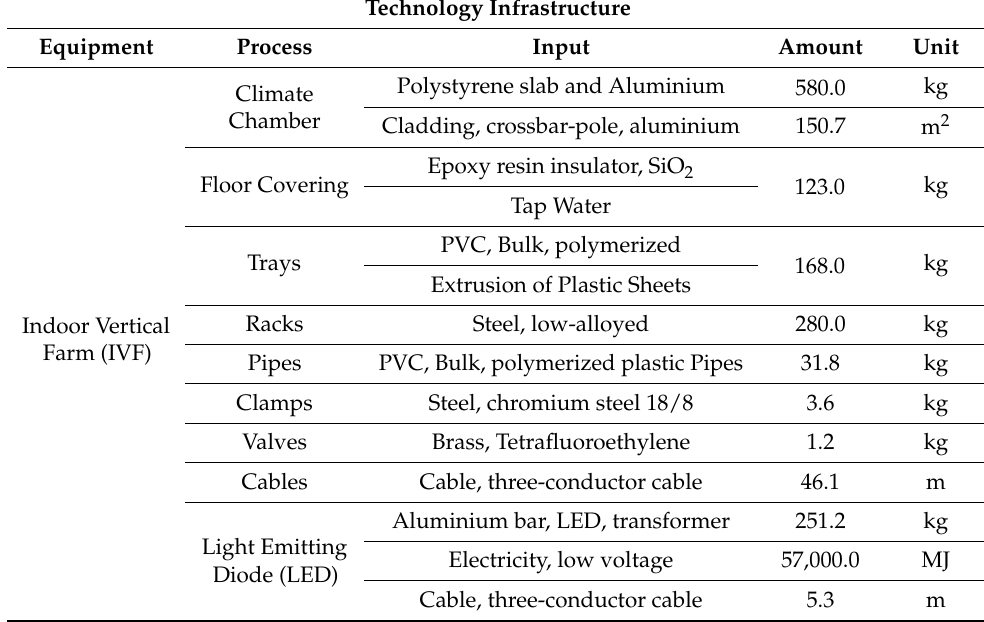
Table 1. LCI Infrastructure of the building-integrated IVF technology, grouped by equipment types of Indoor Vertical Farm (IVF), hydroponic system, work area, Internet of Things (IoT) and Photovoltaic System (PV), the latter applicable to the renewable energy scenarios only (More detailed in Table